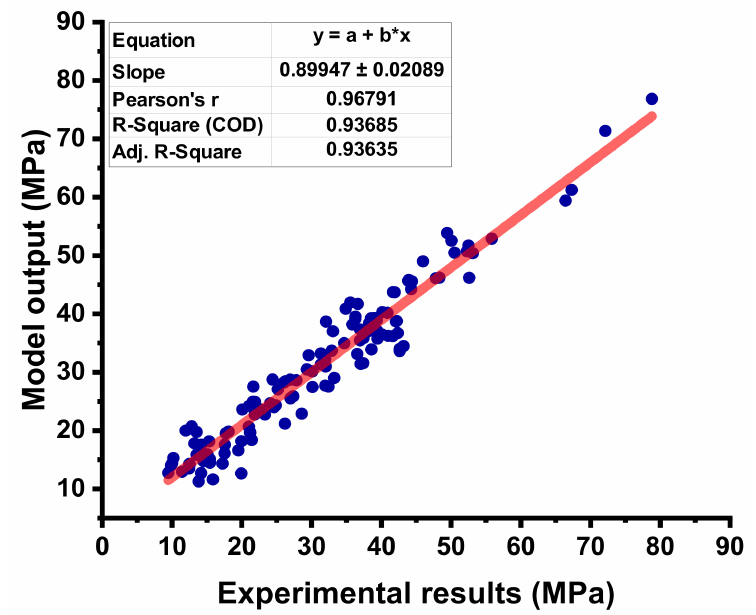
Figure 11. Correlation between the experimental C-S and projected C-S for the BR